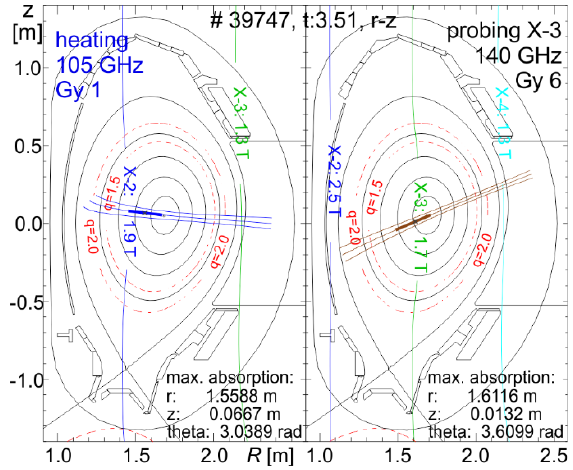
Fig. 12. Cross section, AUG #39747 showing the geometry [8] of the 105 GHz X-2 heating (left) and the 140 GHz probing (right). The main magnetic field strength was chosen such, that for 140 GHz only the X-3 resonance is present in the plasma. The heating beams (left) were launched with a toroidal angle, so that the Doppler shifted resonance is closer to the centre.